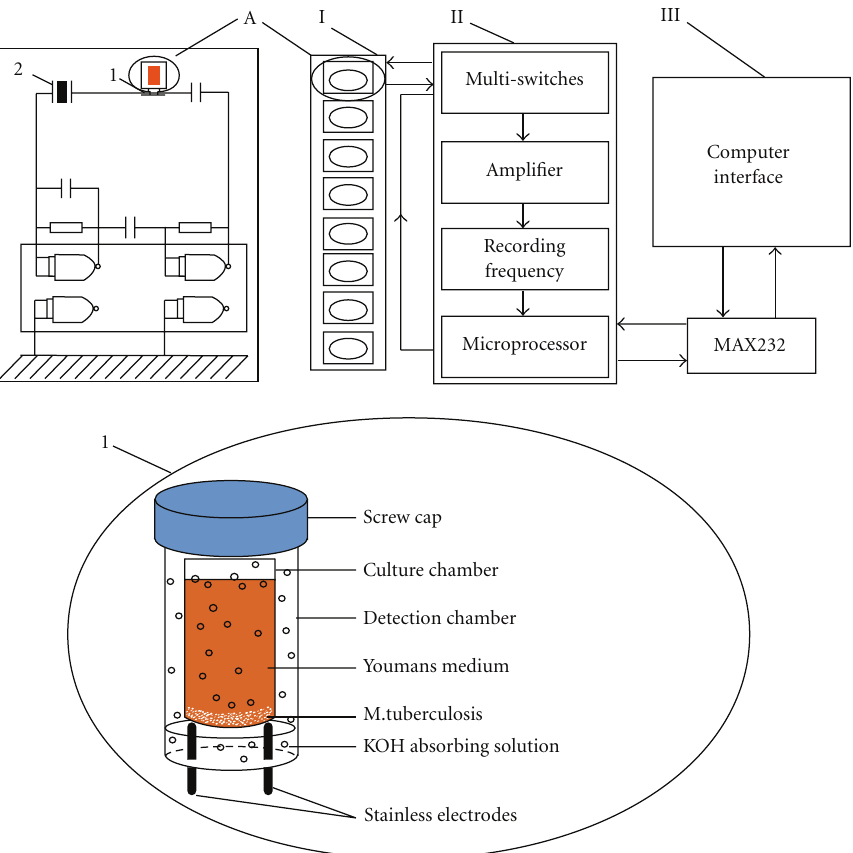
Figure 1: Block diagram drawing of the multichannel series piezoelectric quartz crystal sensor system. The system consists of 3 major components (I) eight samples detection system (A) the circuit of the single oscillator (1) detection cell; (2) 9MHz AT-cut piezoelectric quartz crystal), (II) microprocessor system, (III) data output system; Reprinted with permission from [48]. Copyright 2008, Biosensors.